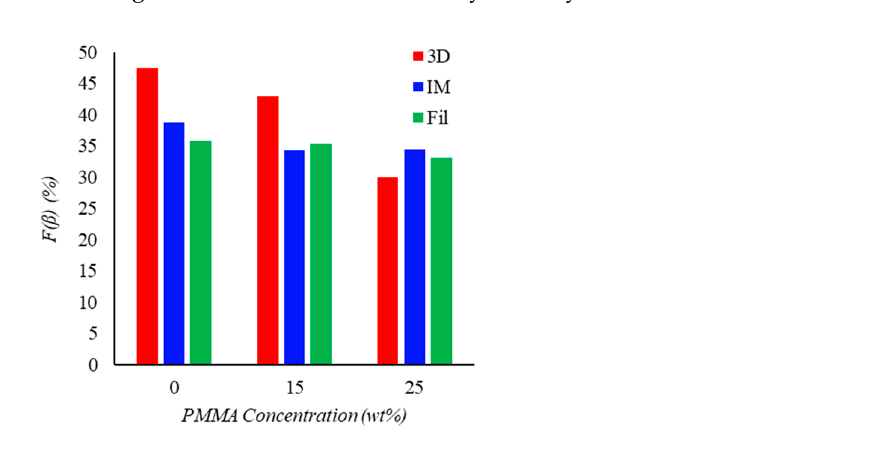
Figure 4. β -phase percent ratio in PVDF/PMMA processed blends as a function of PMMA